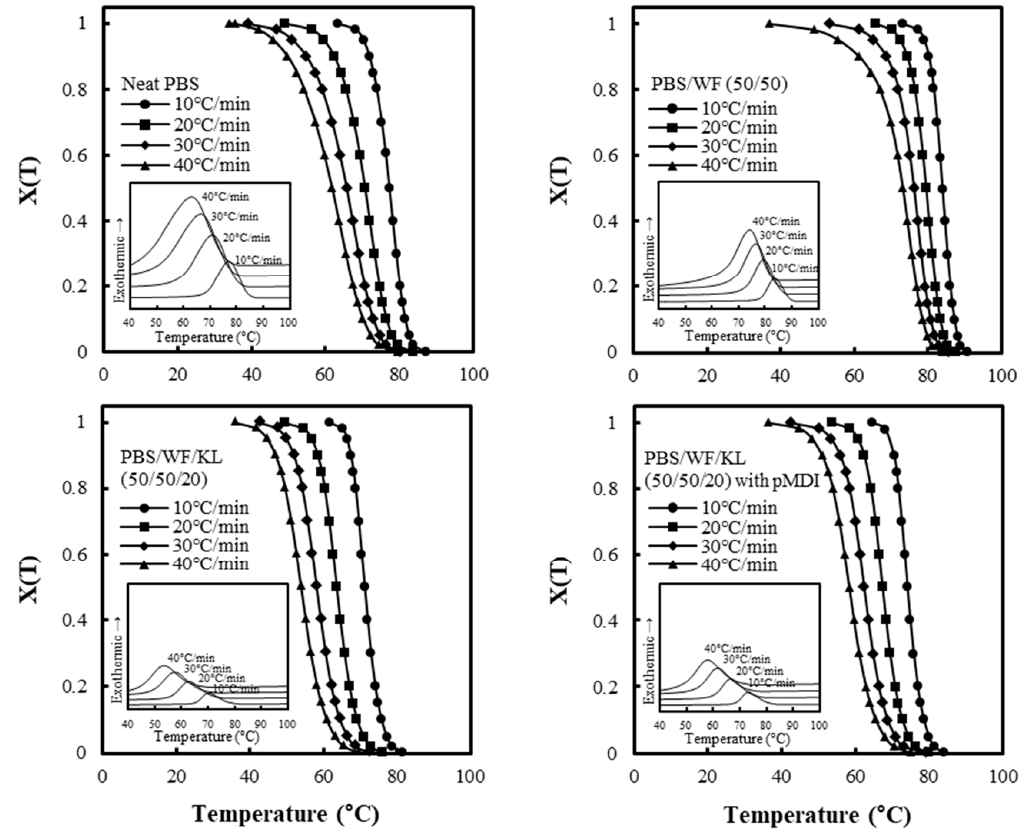
Figure 9. Crystallization exotherms and plots of the relative degree of crystallinity, X(T), versus the temperature for neat PBS, PBS / WF (50 / 50), and PBS / WF / KL (50 / 50 / 20) with and without pMDI at different cooling rates.